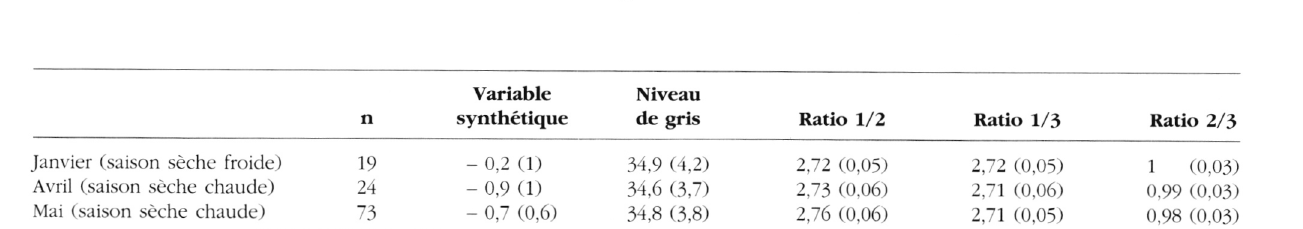
Tableau I. - Moyenne et écarts-type (entre parenthèses) selon l’espèce et le sexe des mesures réalisées sur les ailes (n = nombre d’indi­ vidus, surface en mm2, longueur des segments en mm, niveau de gris entre 0 et 255).